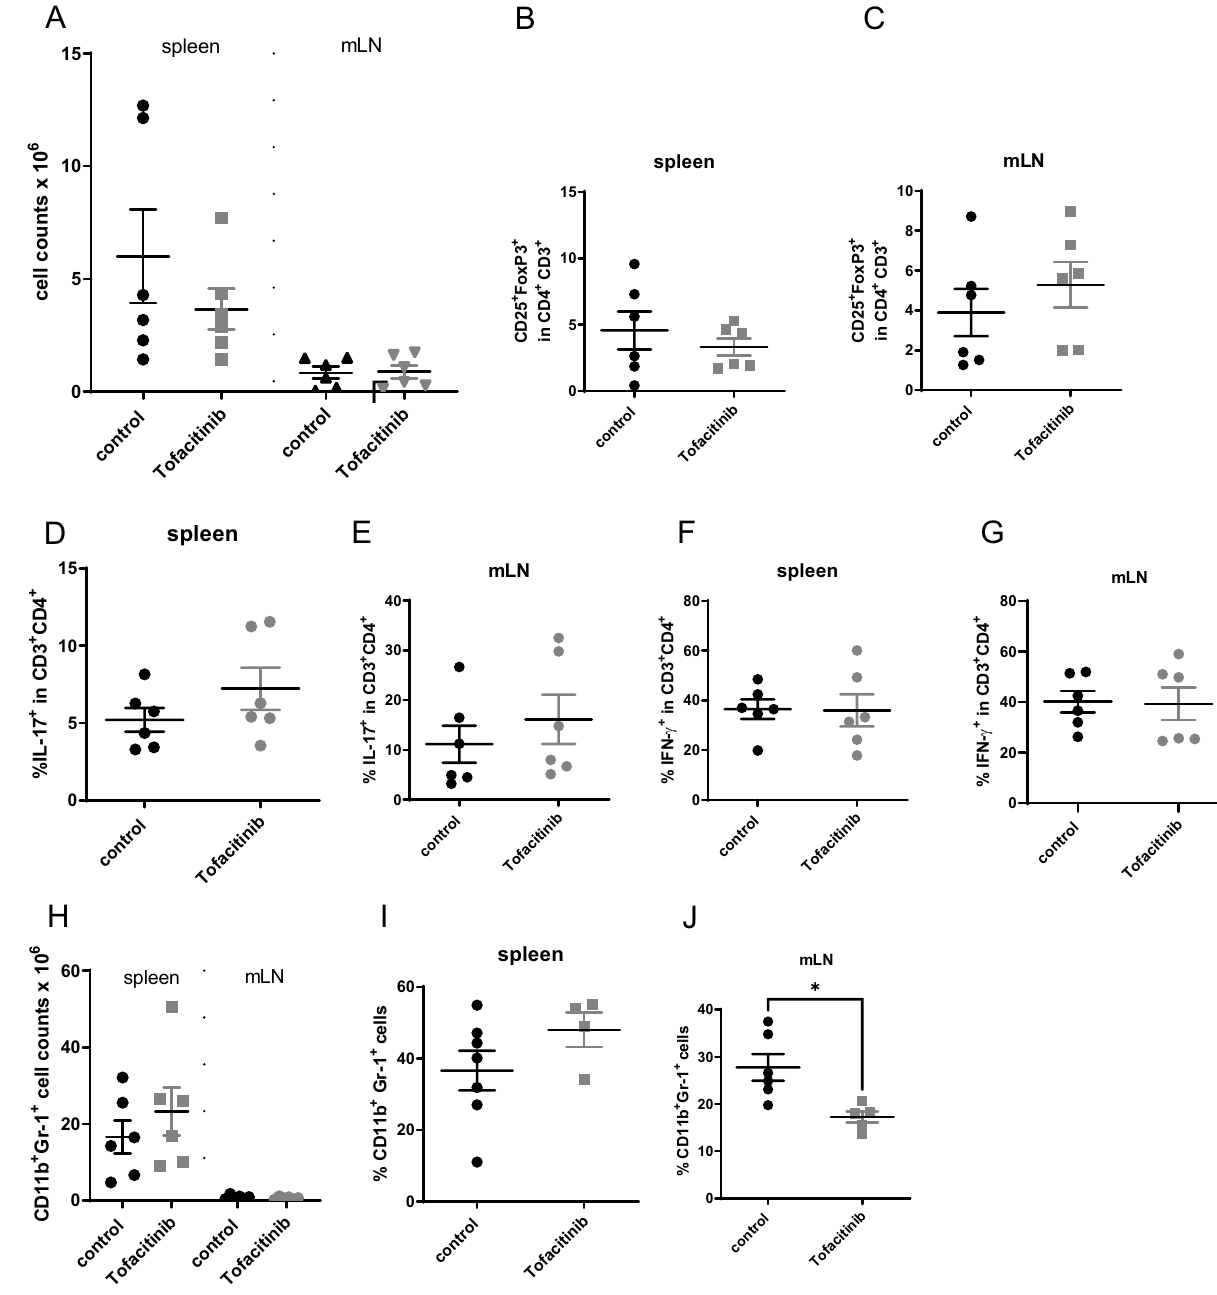
Figure 4. High-dose Tofacitinib treatment does not increase immune cell numbers. ( A ) Absolute numbers of immune cells within the spleens and mLNs assessed by flow cytometry. ( B ) Statistical analysis of CD4+ CD3+ CD25+ Foxp3+ cells in the spleen, N = 6 mice in each group). ( C ) Statistical analysis of CD4+ CD3+ CD25+ Foxp3+ cells in the mLNs, N = 6 mice in each group). ( D ) Statistical analysis of IL-17+ T cells within the spleen, N = 6 mice in each group). ( E ) Statistical analysis of IL-17+ T cells within mLNs, N = 6 mice in each group). ( F ) Statistical analysis of IFN-γ+ T cells within the spleen, N = 6 mice in each group). ( G ) Statistical analysis of IFN-γ+ T cells within mLNs, N = 6 mice in each group). ( H ) Absolute numbers of CD11b + Gr-1 + cells within the spleen and mLNs assessed by flow cytometry, N = 6 mice in each group. ( I ) Statistical analysis of CD11b + Gr-1 + cells within spleen, N = 6 control mice and N = 4 Tofactinib treated mice. ( J ) Statistical analysis of CD11b + Gr-1 + cells within spleen, N = 6 control mice and N = 5 Tofacitinib treated mice (* = 0.0112). For all data sets error bars indicate SEM, two-tailed unpaired t-tests were used to test for